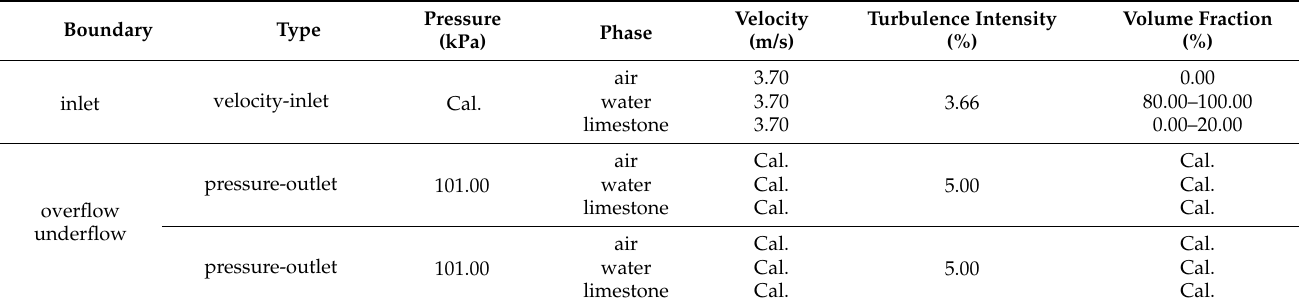
Table 1. Boundary conditions of laboratory Φ 150 mm